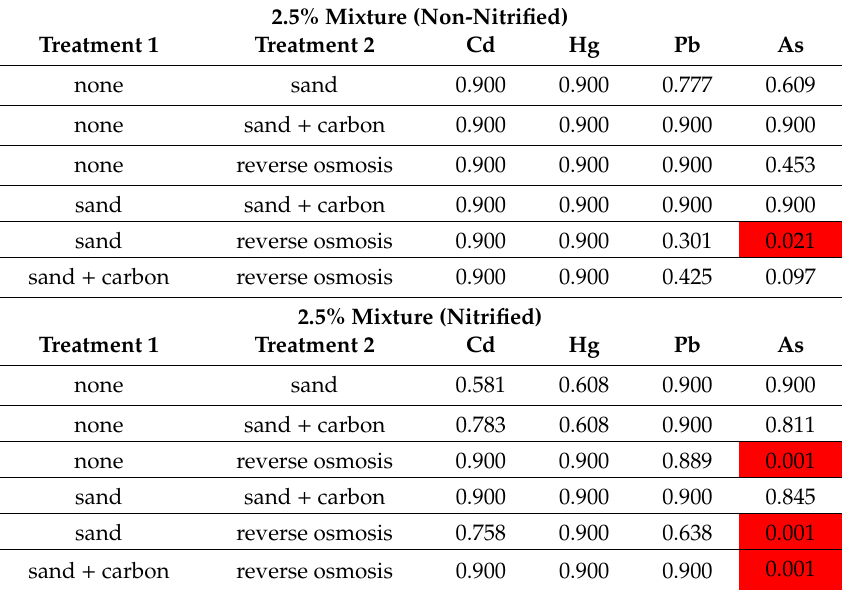
Table 5. Significant di ff erences between methods for each metal were calculated using Tukey HSD method and the p -values are presented for each treatment comparison. Significant di ff erences ( p < 0.05) are highlighted in red for convenience.